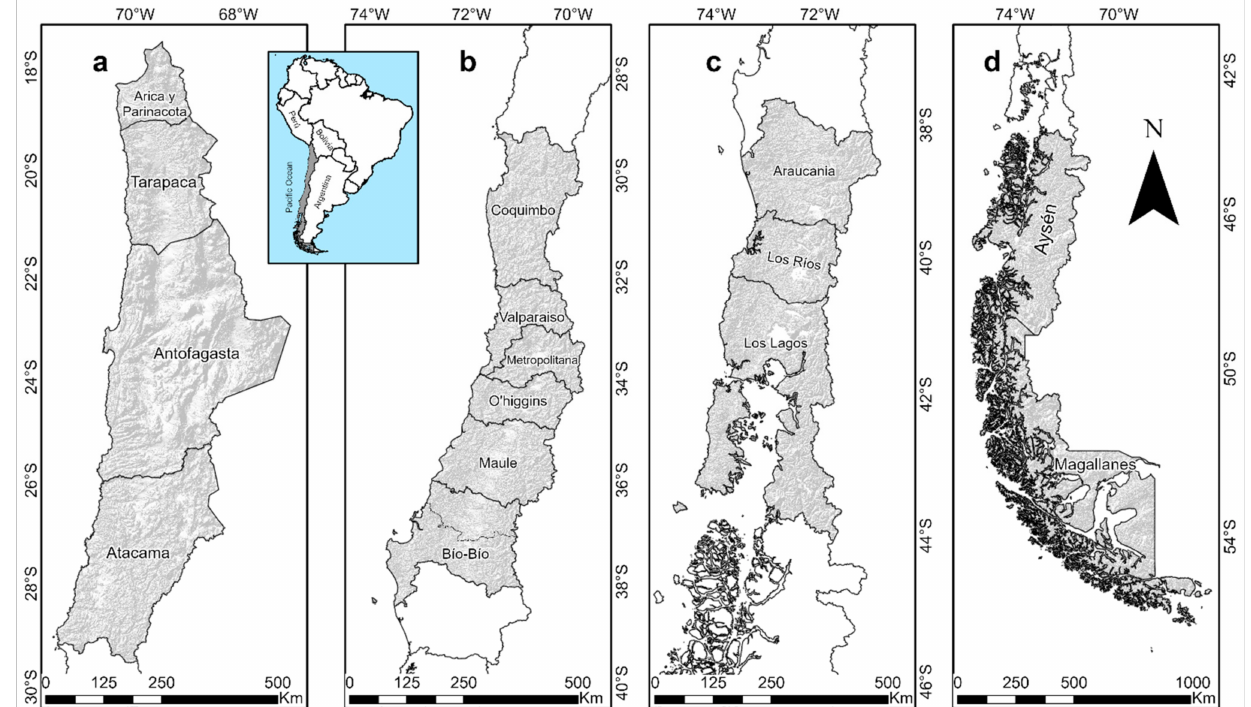
Figure 1. Study area: North ( a ), Central ( b ), Central South ( c ), and Austral ( d